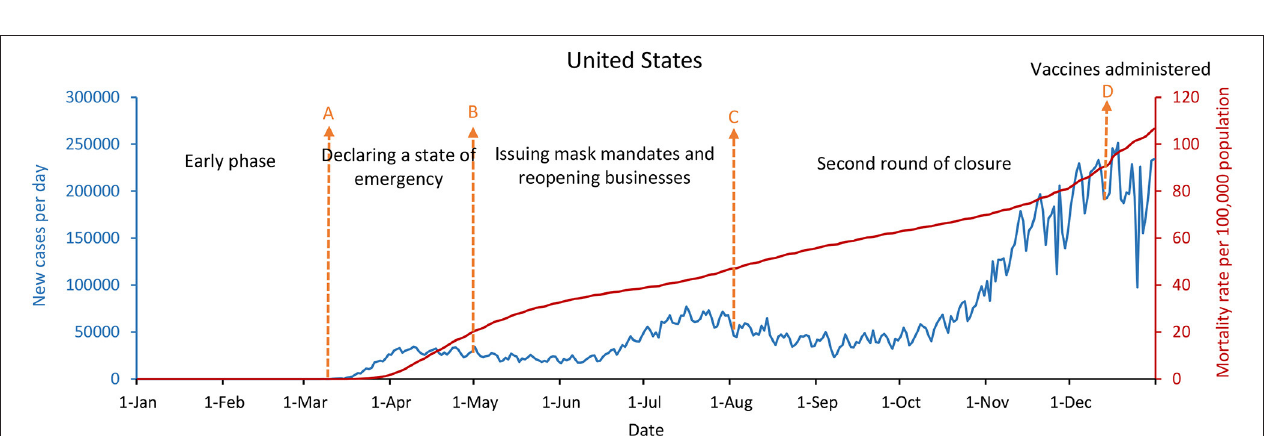
FIGURE 3 | Singapore’s COVID-19 epidemic curves and population mortality rate (between January 1 and December 31, 2020). (A) On March 24, 2020, the Multi-Ministry Task Force announced stricter measures. (B) Starting on June 2, relaxing measures and implementing “Safe Reopening.” (C) Starting on June 19, implementing “Safe Transition.” (D) Starting in August, continuously implementing “safe transition,” and cautious reopening. (E) Starting on December 28, implementing “Safe Nation.”